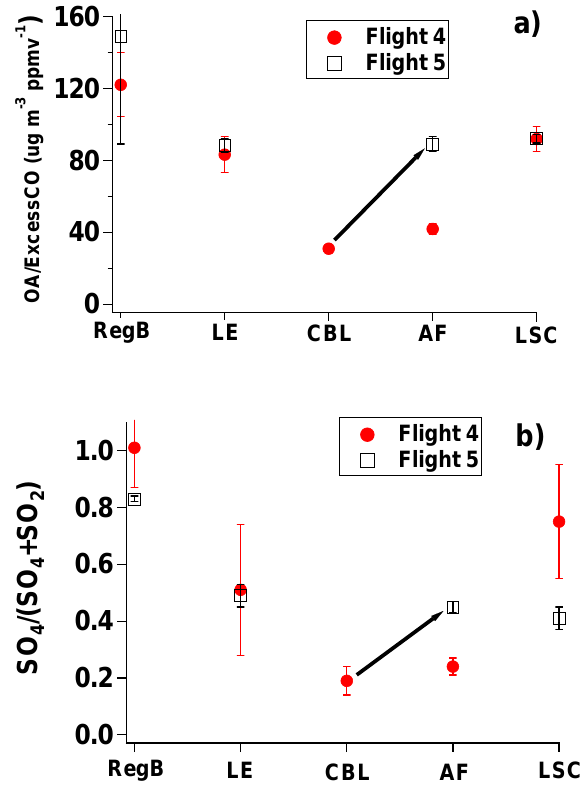
) as a function of /(SO 2 +SO 2 − 4 4